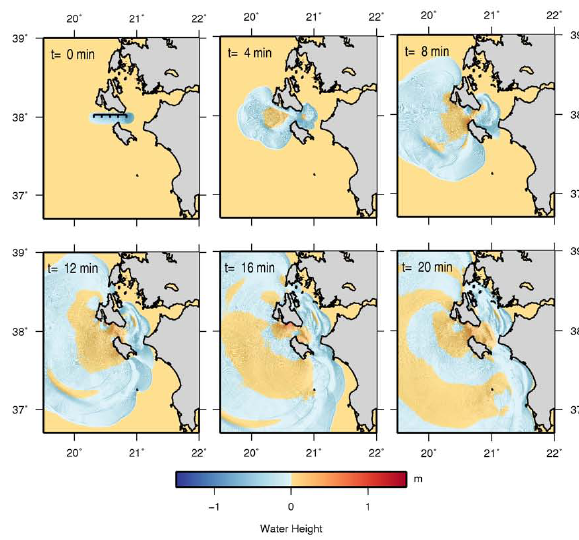
Fig. 10. Snapshots of the tsunami propagation from the source 4 (Cephalonia North fault) at 4-min intervals.